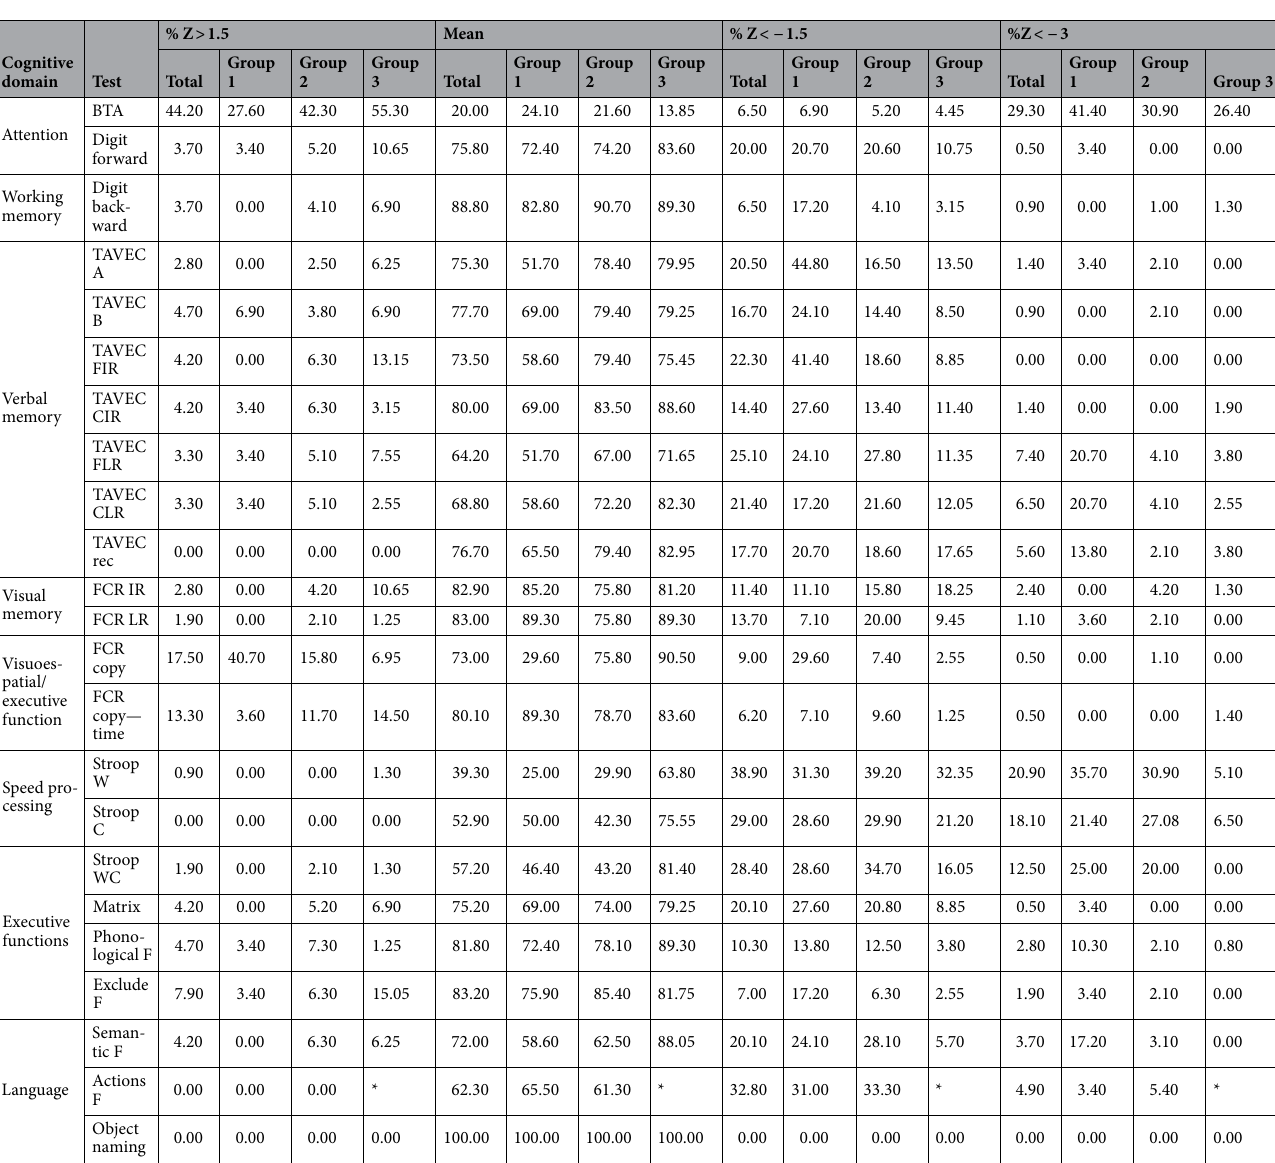
Table 4. Percentage of patients with standardized scores in the mean, above the mean (Z > 1.5), with mild impairment (Z < − 1.5) and severe impairment (Z < −